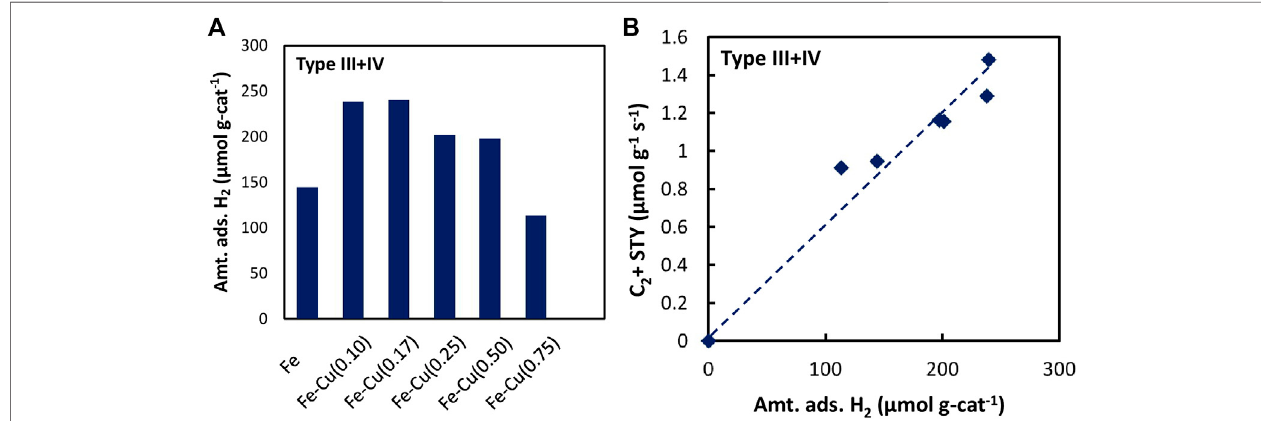
FIGURE9|(A) TheamountoftypeIII+IVadsorbedH 2 ontheFe-Cu(X)/Al 2 O 3 catalysts,and (B) TheeffectofamountoftypeIII+IVadsorbedH 2 onthespace-time yield (STY) of C 2+ hydrocarbons over the Fe-Cu(X)/Al 2 O 3 catalysts.